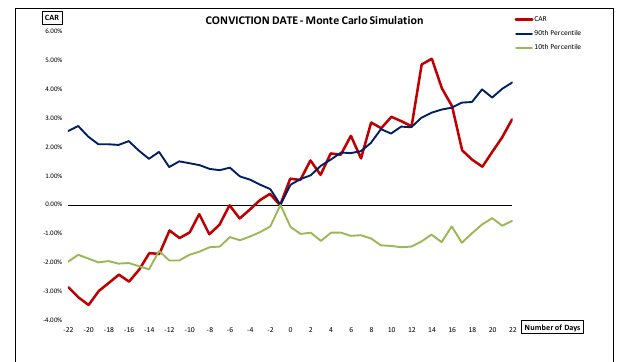
Figure 5: Monte Carlo simulation results of cumulative abnormal returns for the conviction event window